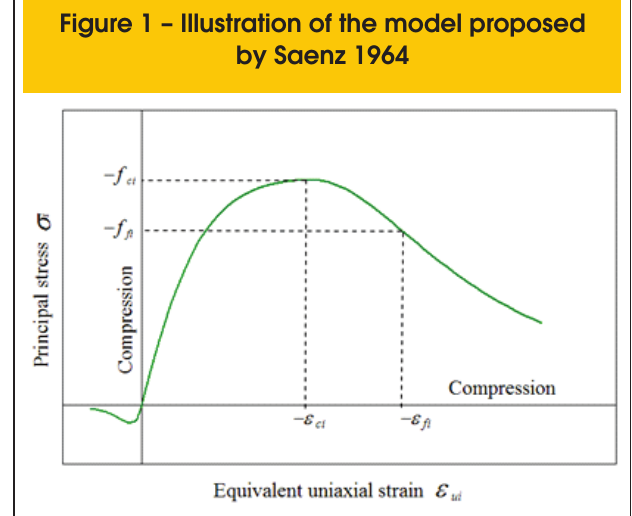
Figure 1 – Illustration of the model proposed by Saenz